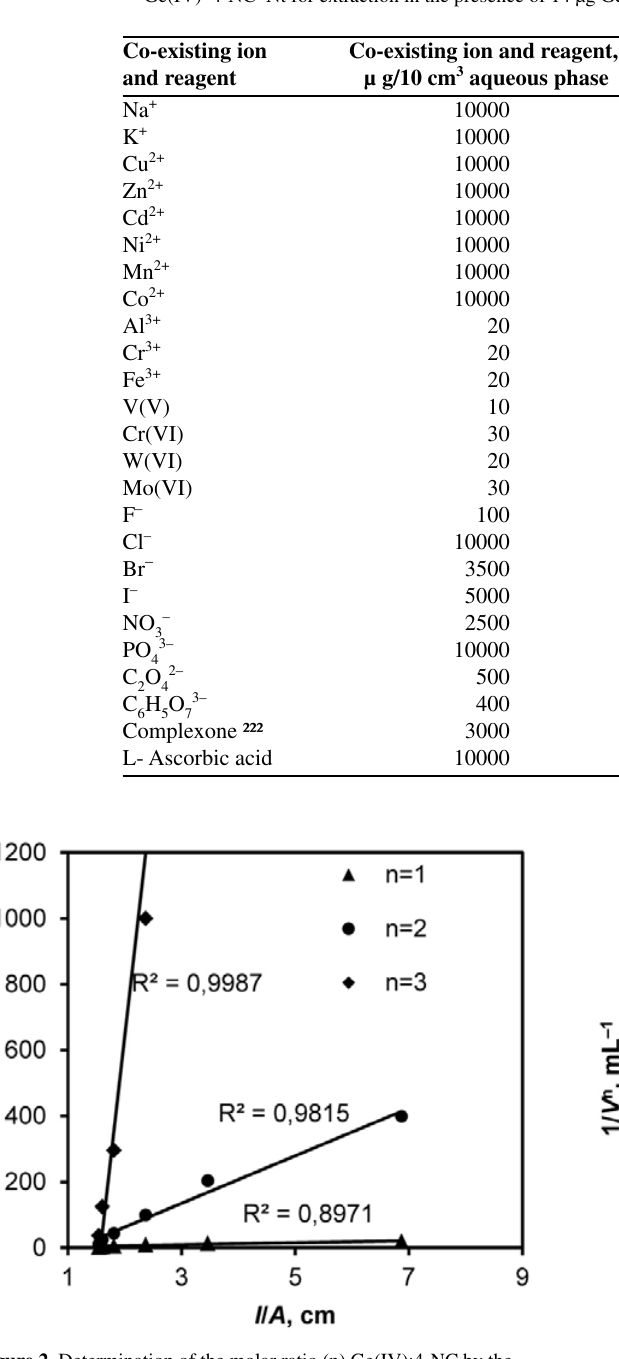
Figure 2. Determination of the molar ratio (n) Ge(IV):4-NC by the method of Asmus. C